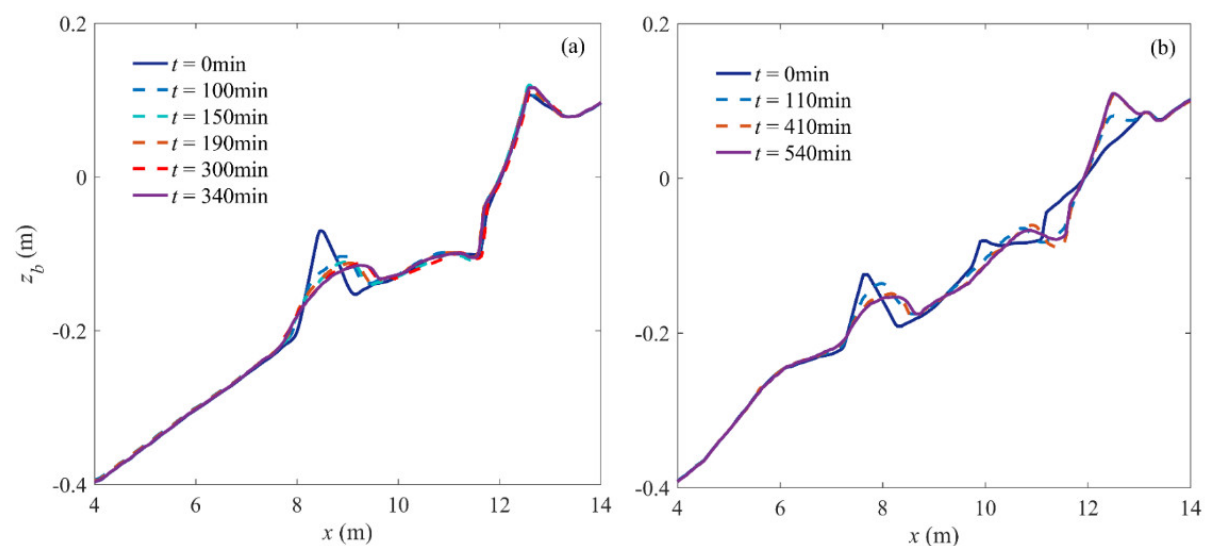
Figure 3. Experimental results of beach profile evolution in case A1_2 ( a ) and E1_1 ( b ). It can be noted that both the shoreface nourishments in these two cases tend to be equilibrium. The equilibrium trends of the shoreface nourishment are described by the integration of the magnitudes of bed elevation changing rates (i.e., cross-shore cumulative sediment transport gradient) in the active zones. The active zones for cases A1_2 and E1_1 are from x = 8 m to x = 10 m and x = 7 m to x = 9 m,